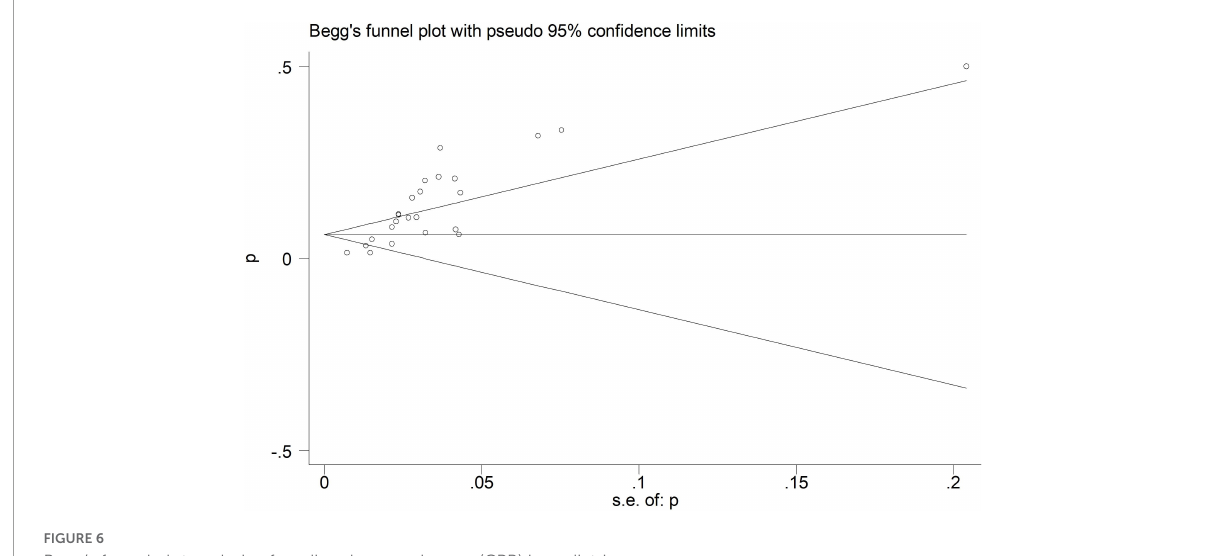
FIGURE6 Begg’s funnel plot analysis of cardiopulmonary bypass (CPB) in pediatrics.